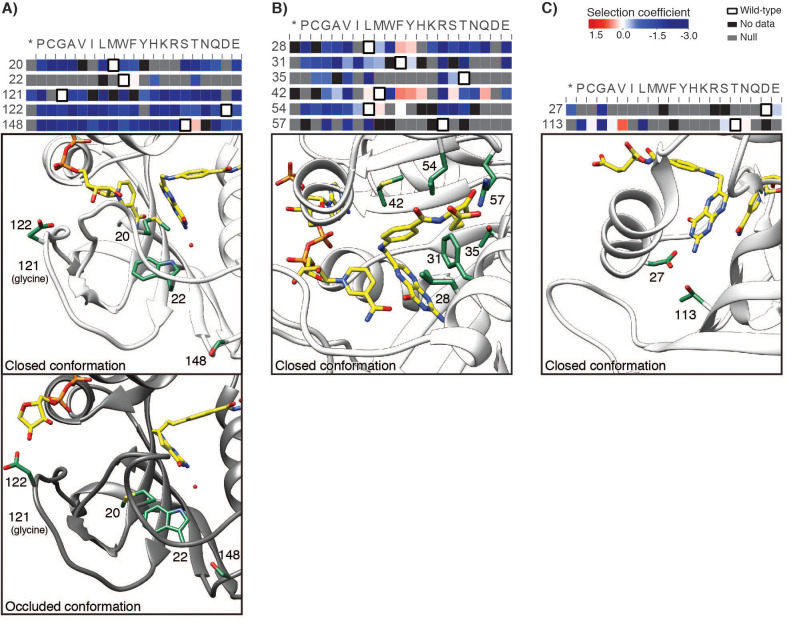
Residues previously known to have a functional role shown on the DHFR structure.(A–C) Functionally important residues are colored green, labeled, and shown with slices of the –Lon heatmap (heatmap coloring by selection coefficient is as in Figure 2). The wild-type residue is outlined in black. Positions 22, 27, 35, 57, and 113 are Intolerant, and positions 20, 28, 31, 42, 54, 121, 122, and 148 are Deleterious. In A) the closed (upper, white, PDB ID: 3QL3) and occluded (lower, grey, PDB ID: 1RX4) conformation are shown to illustrate alternate stabilization of the two conformations by D122 (closed) (Miller and Benkovic, 1998) and S148 (occluded) (Miller et al., 2001). For all other panels, only the closed conformation is shown.